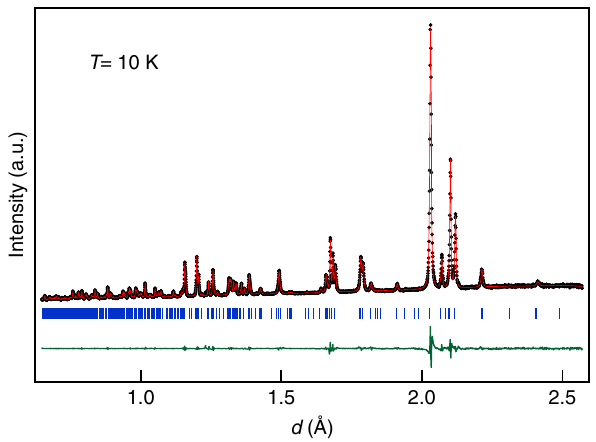
Fig. 7 Le Bail fi ts for the neutron diffraction patterns at 10 K. The experimental data, fi tted curve and the residue are shown by circles (black), red continuous line, and green continuous line, respectively. The tick marks (blue) represent the Bragg